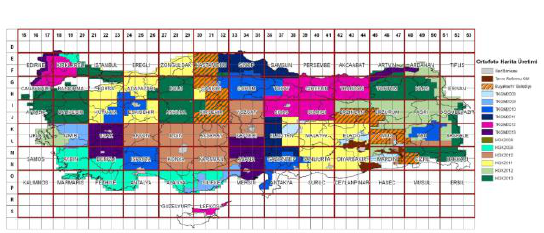
Figure 18. Orthophoto product area Orthophotos covering areas found within